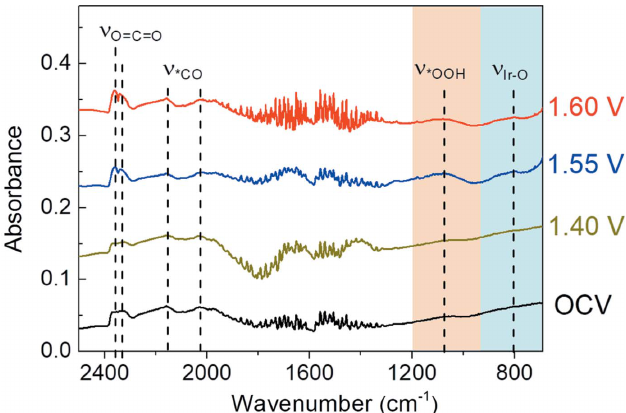
Figure 4 FTIR spectra of the commercial IrO 2 catalysts during the OER. To clearly present the change of FTIR spectra, a constant y -axis offset method is employed to separate plots along the y -axis, where the y -axis offset values for the plots under OCV, 1.40 V, 1.55 V and 1.60 V are 0, 0.1, 0.2 and 0.3,